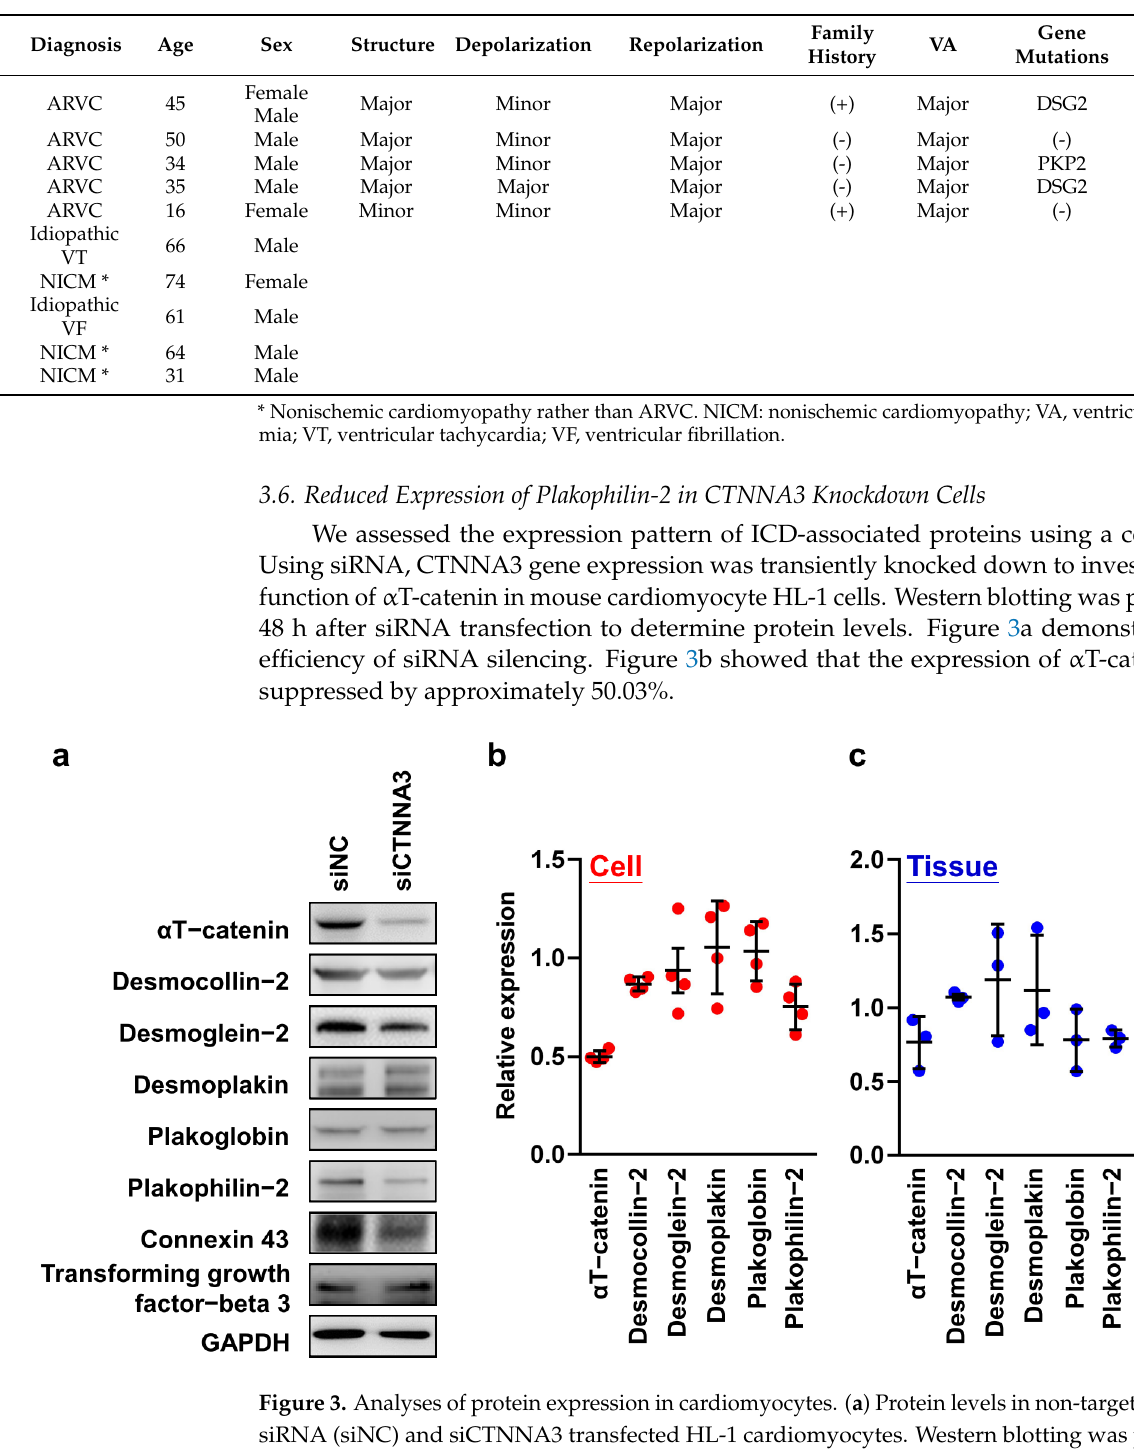
Table 4. Baseline characteristics and fulfilled Task Force Criteria of clinical patients with and without definite ARVC for validation of IHC staining.